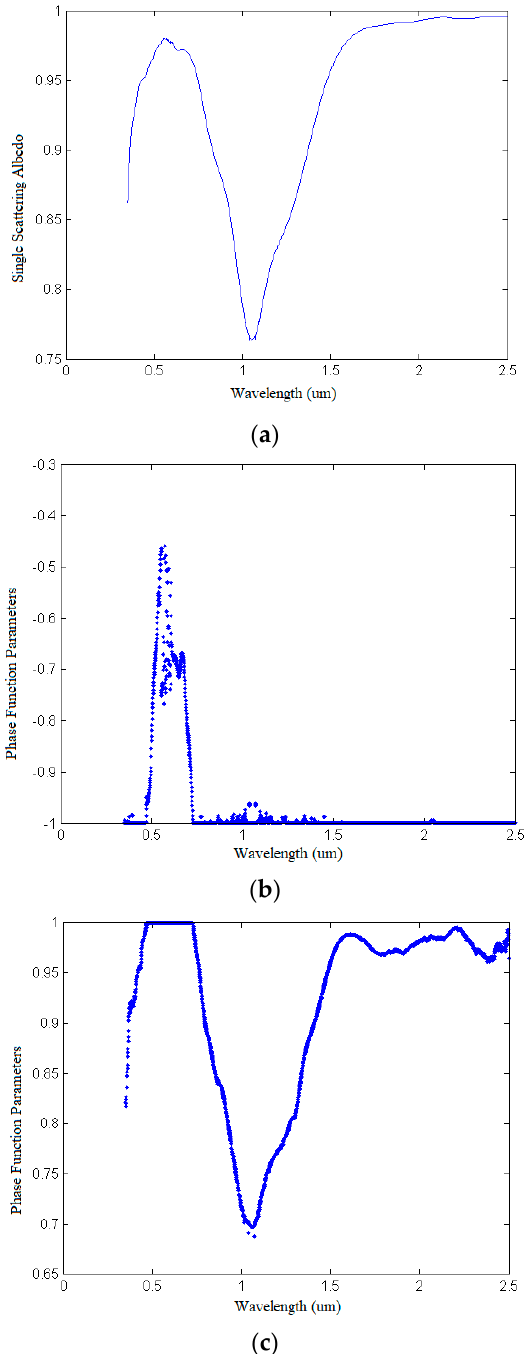
Figure 9. Photometric parameters of olivine: ( a ) SSA (w), ( b ) Legendre polynomial coefficients of phase function b, and ( c ) Legendre polynomial coefficients of phase function c.